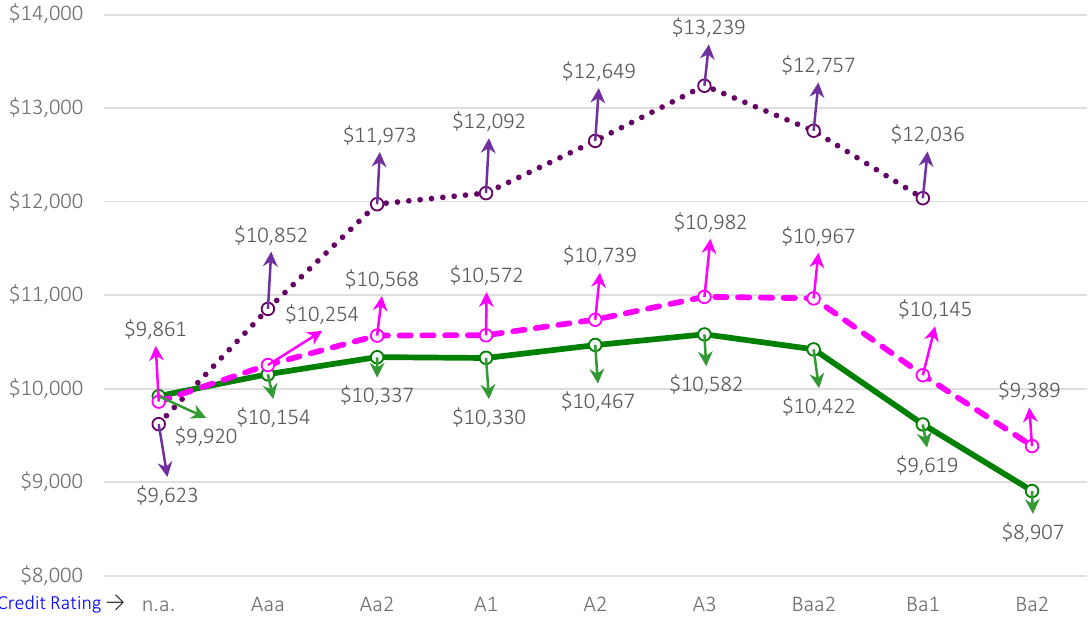
) Mean Outcomes for Five Small Tests, Five Large Tests, and Five FS Tests . Figure 2. Firm Value ( V L Mean V outcomes (in millions of dollars) are plotted against credit ratings. The solid, dashed, and L dotted lines represent small , large , and financial service ( FS ) firms, respectively. NOTE: “n.a.” stands for not applicable as this is the unlevered